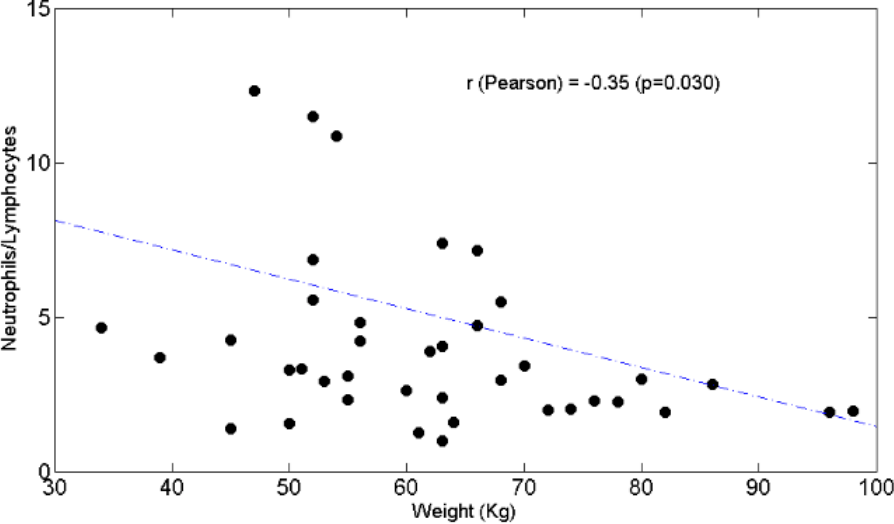
Figure 4. Scatter plot of the neutrophils/lymphocytes ratio (y axis) as a function of weight (x axis). The value of Pearson’s correlation coefficient and corresponding p value are also reported. Figure 5. The number of chemotherapy cycles is not significantly linked to body weight (Kg).